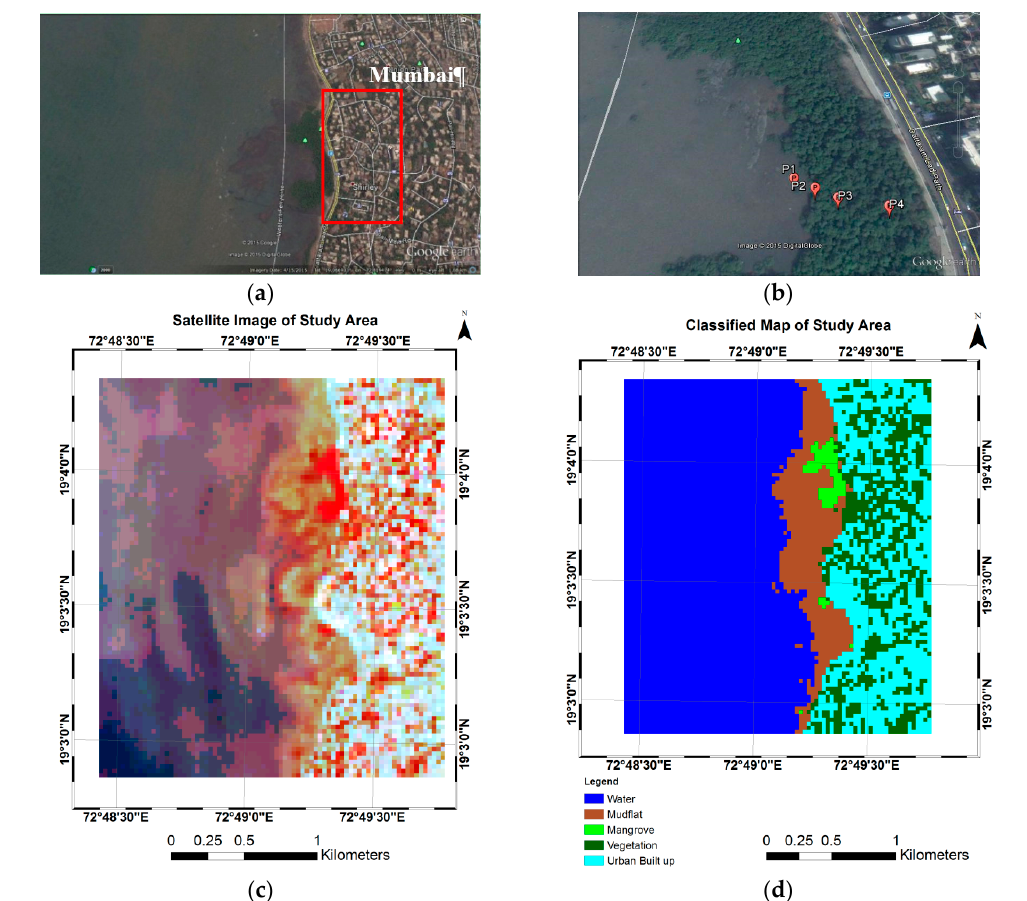
Figure 2. ( a ) Vegetation area off Mumbai (google image); ( b ) domain showing the vegetation area and the wave measurement locations (P1, P2, P3, and P4); ( c ) satellite image; ( d ) classified image of the study area.